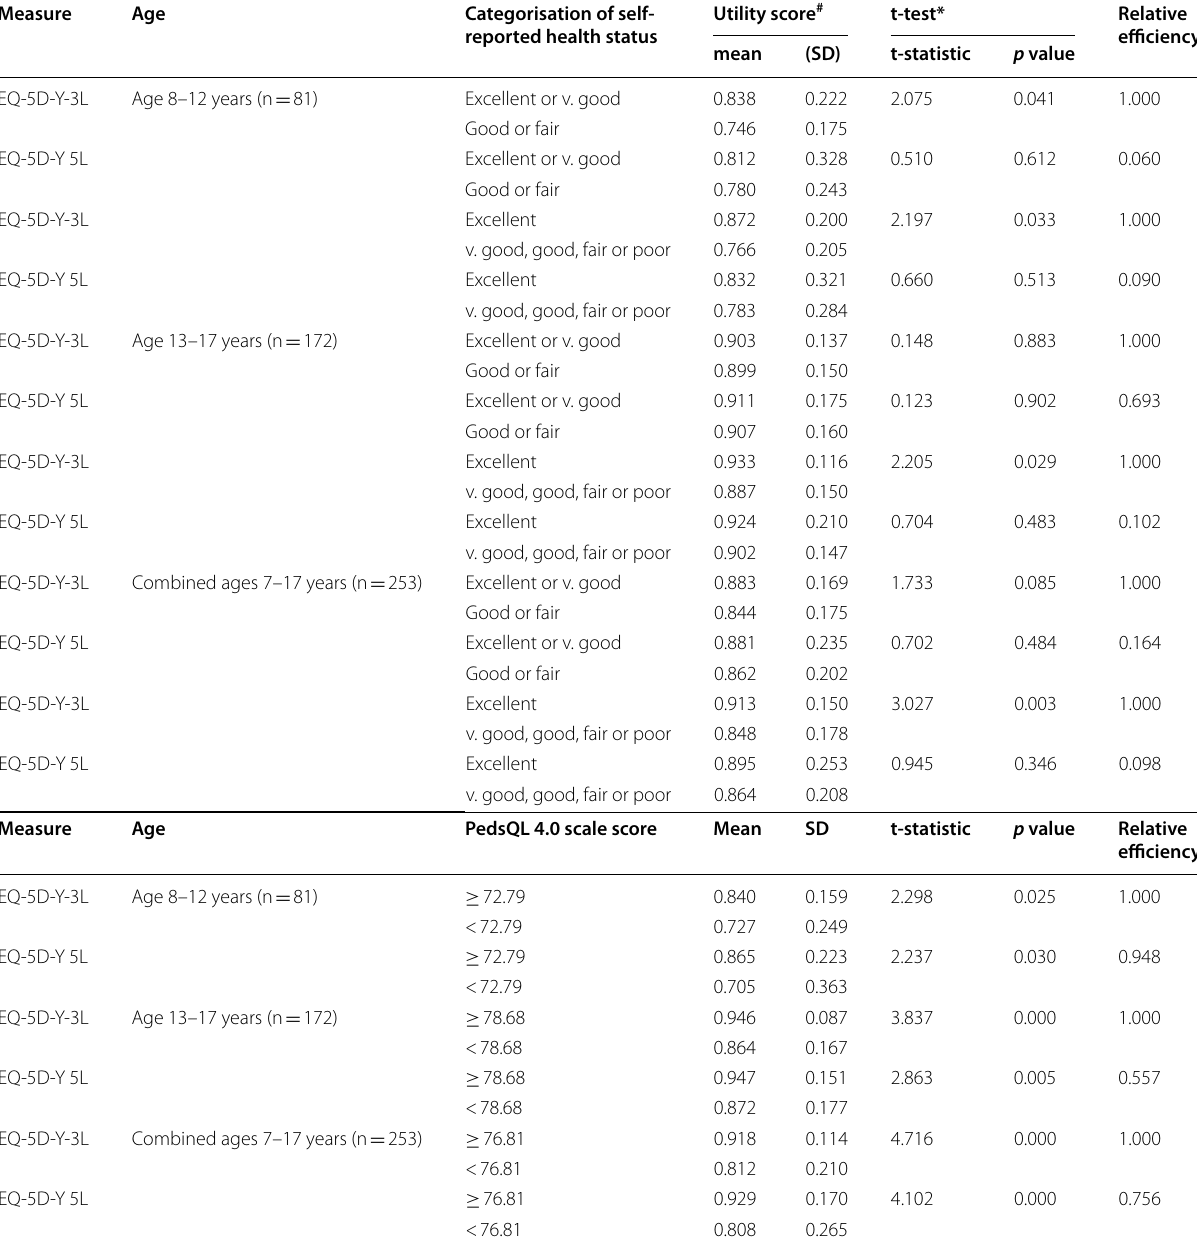
Table 6 Efficiency of the EQ-5D to detect differences in self-reported health